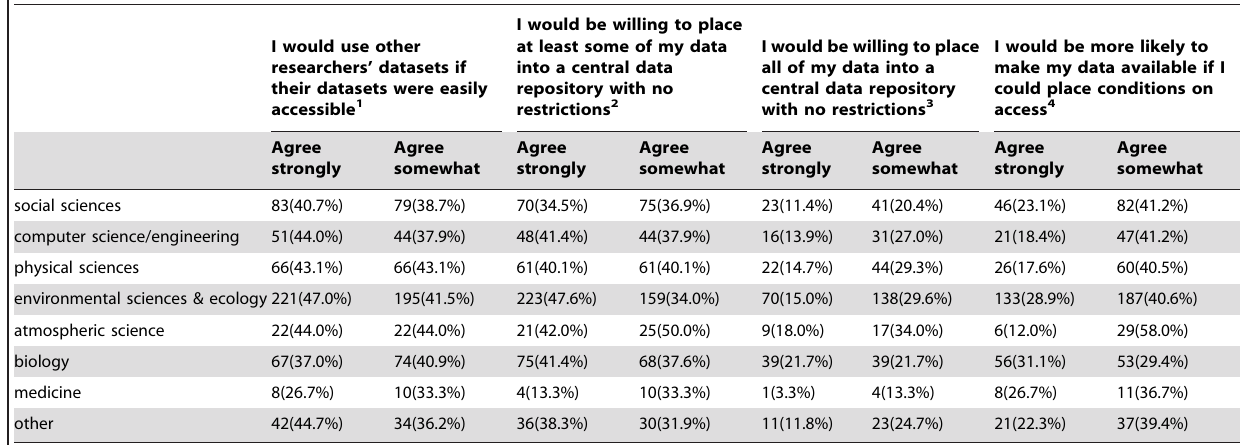
Table 19. Conditions for data sharing by subject discipline.